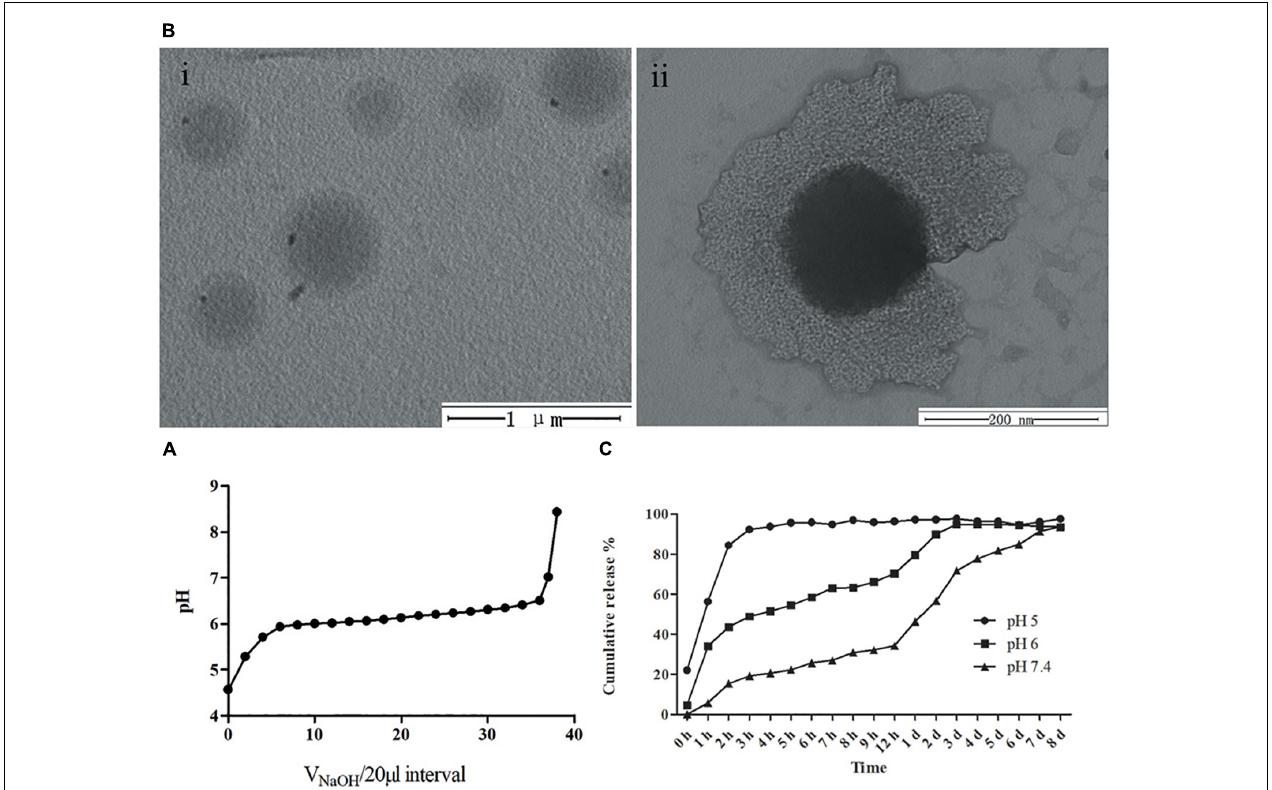
FIGURE 2 | (A) pH titration curve of mPEG-b-PDPA polymer; (B) transmission electron microscopy (TEM) image of free micelles at pH 7 (i) , and typical core-shell structure image of micelle (ii) . (C) Cumulative drug release curves of bedaquiline-loading micelles at pH 5, 6, and 7.4 PBS buffer.